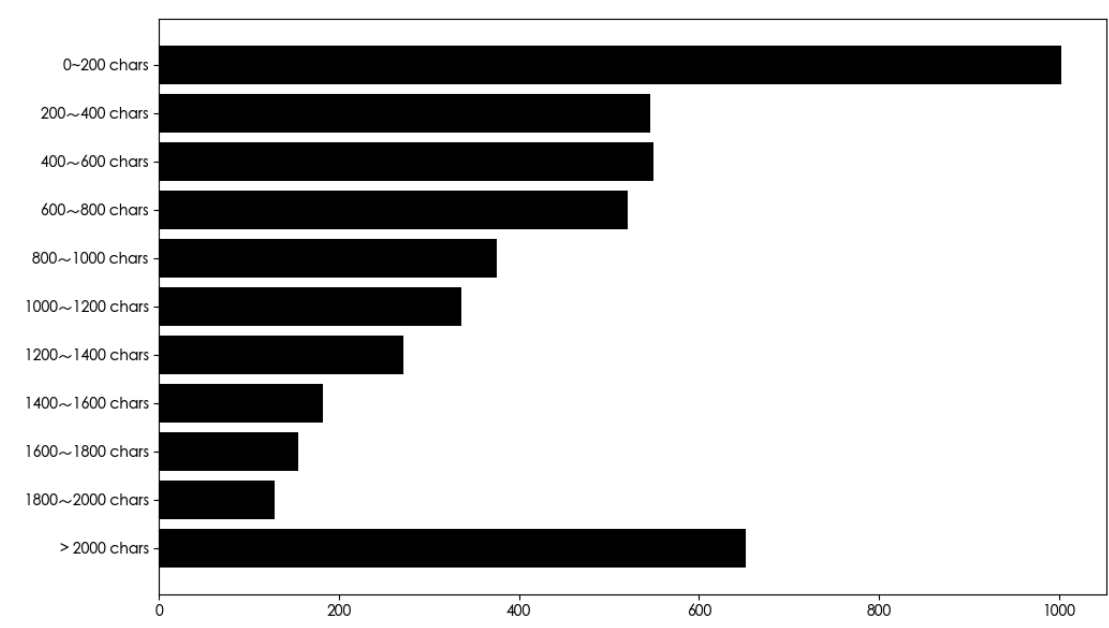
Figure 1. Earthquake-related emergency text length